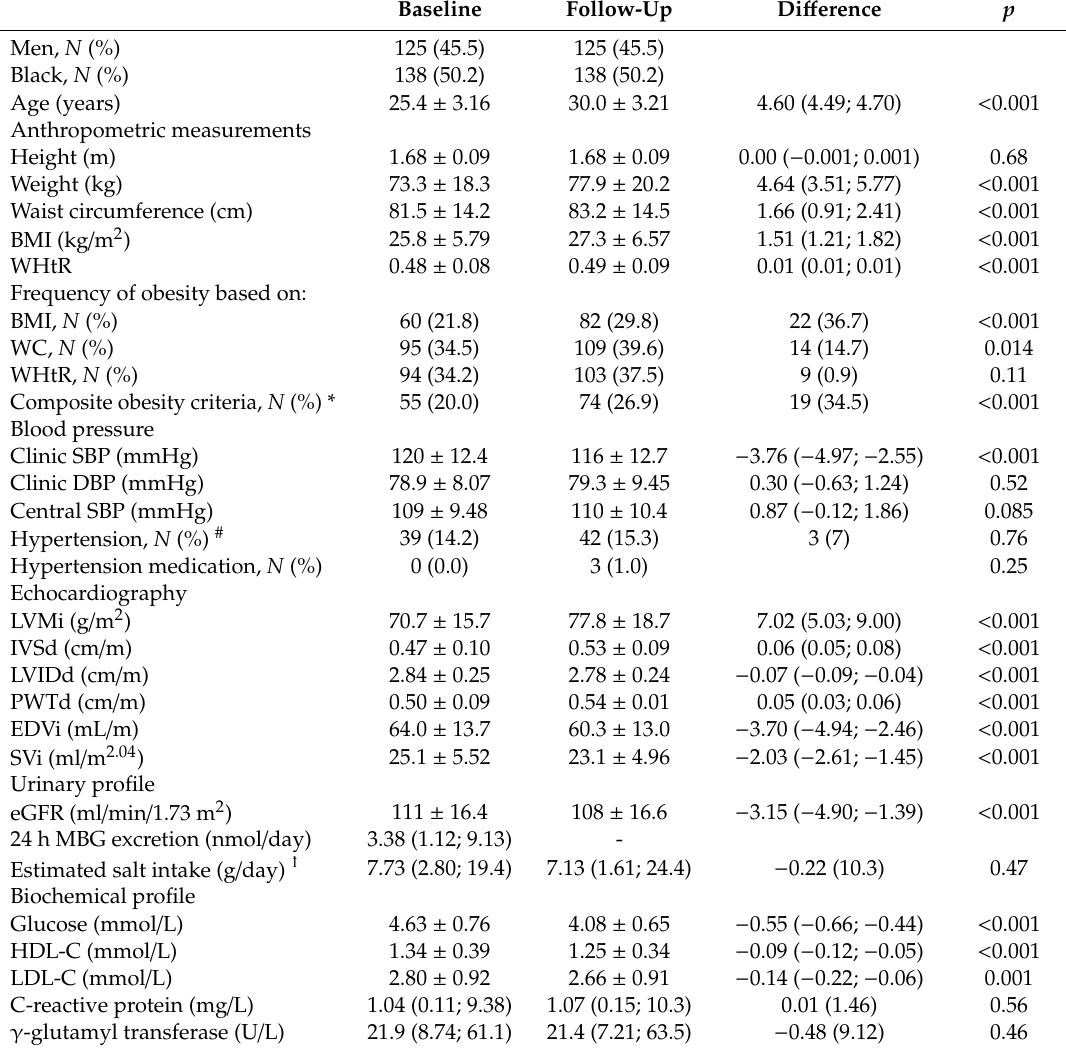
Table 1. Characteristics of 275 participants followed over 4.5 years.